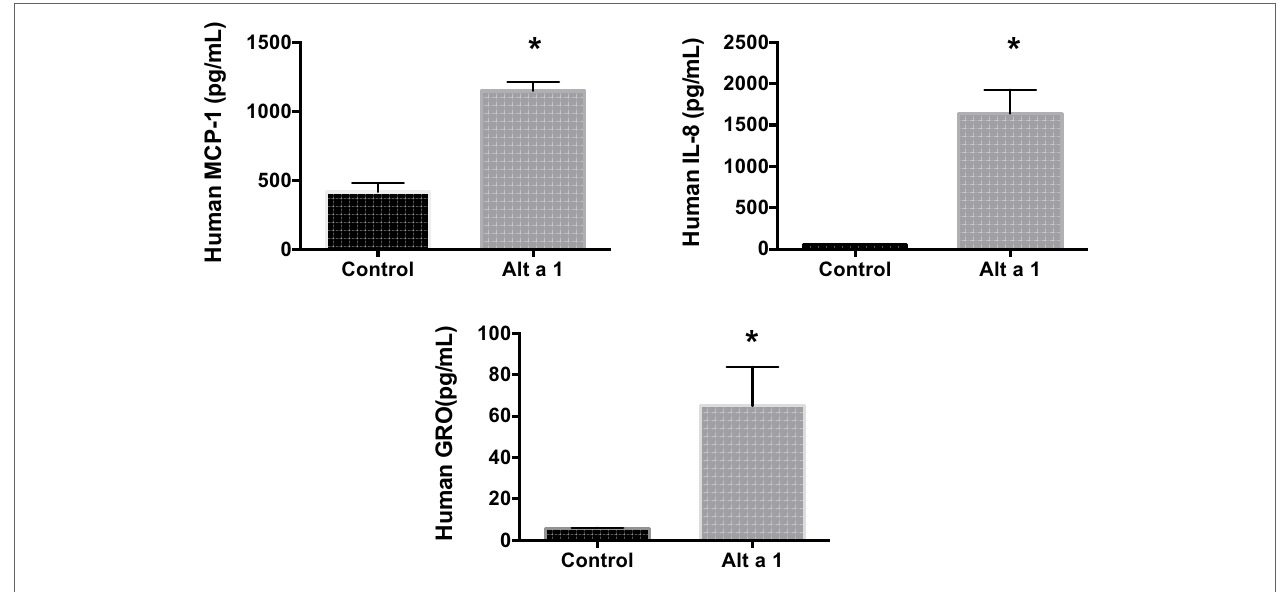
FigUre 3 | Induction of cytokines and chemokines in BEAS-2B cells treated with Alt a 1. 5.0 × 10 5 human BEAS-2B cells were treated with 50 µg rAlt a 1 for 24 h. Supernatant was collected and cytokine/chemokine levels were determined using BIOLEGEND ELISAMAX [MCP-1 (CCL2), IL-8, and GRO-a/b/g (CXCL1/2/3)]. Data are represented as mean (SD). After testing for homogeneity of variances, Tukey’s HSD was performed and adjusted (* p <